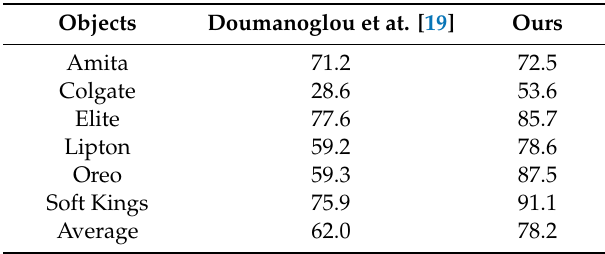
Table 6. Detection rates of methods on the Doumanoglou dataset